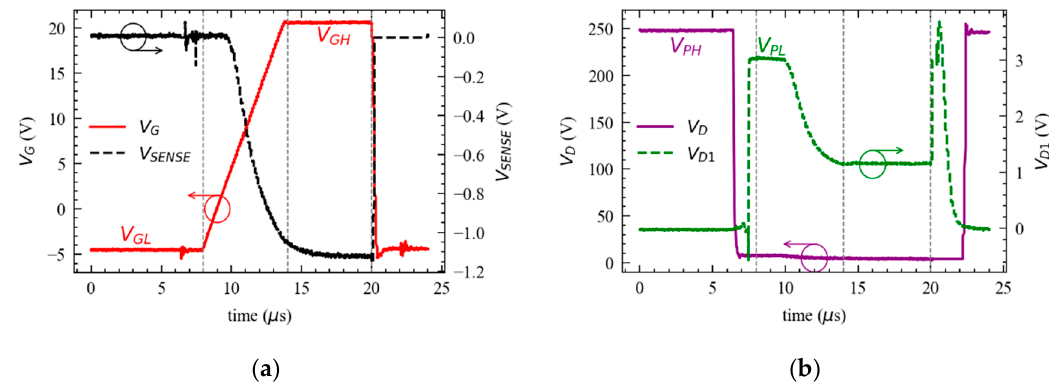
Figure 2. ( a ) Gate voltage ( V G ) is swept for extracting V TH and a stable 20 V level is held at the end of the ramp to ensure a stable current and voltage level for a correct R ON extraction. ( b ) V D is monitored during the off-state stress phase, while V D1 is the signal provided by the clamping circuit ( M 1 , R 1 , D 1